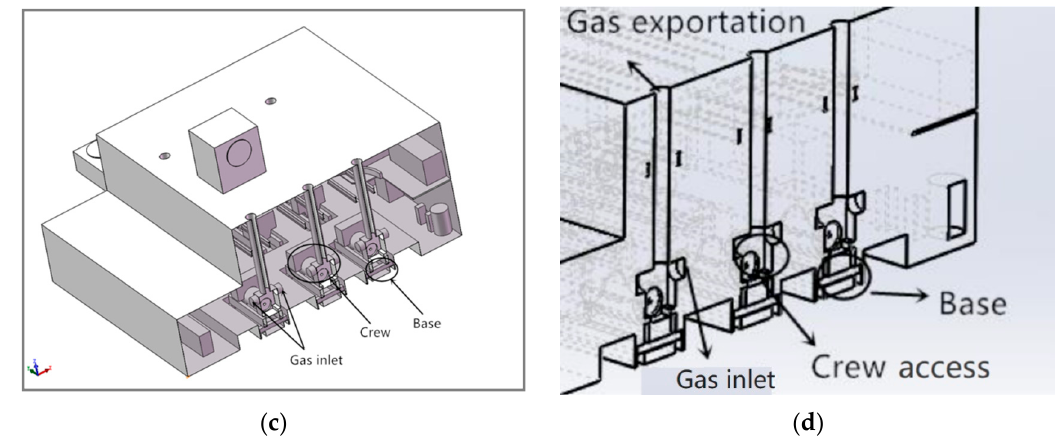
Figure 2. ( a ) Overall layout of engine room; ( b ) Details of the diesel engine module; ( c ) Ventilation design; ( d ) Exhaust gas passage.